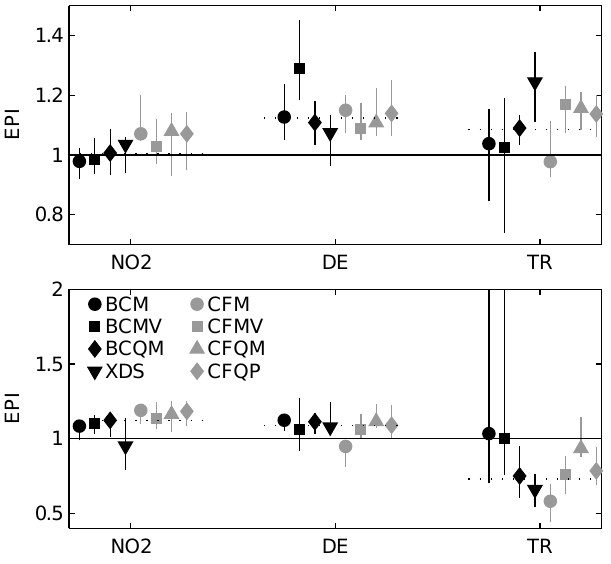
Figure 4. EPI for each SDM for NO2, DE, and TR for winter (top) and summer (bottom). The markers indicate the median and the lines represent the range covered by the 25th and 75th percentiles. All results are for the 1-year level and temporal aggregation of 1 day. Note the different scales used in the y axis for winter and for